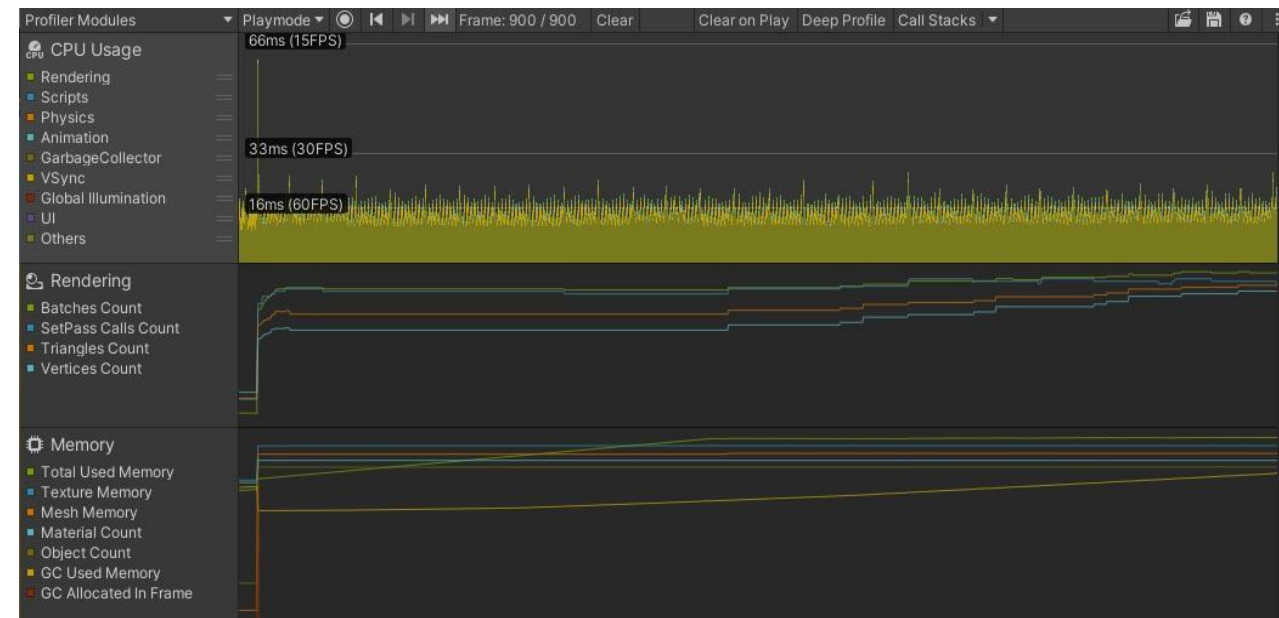
Figure 11. Profiler results for the beginning of the optimized version of the game.